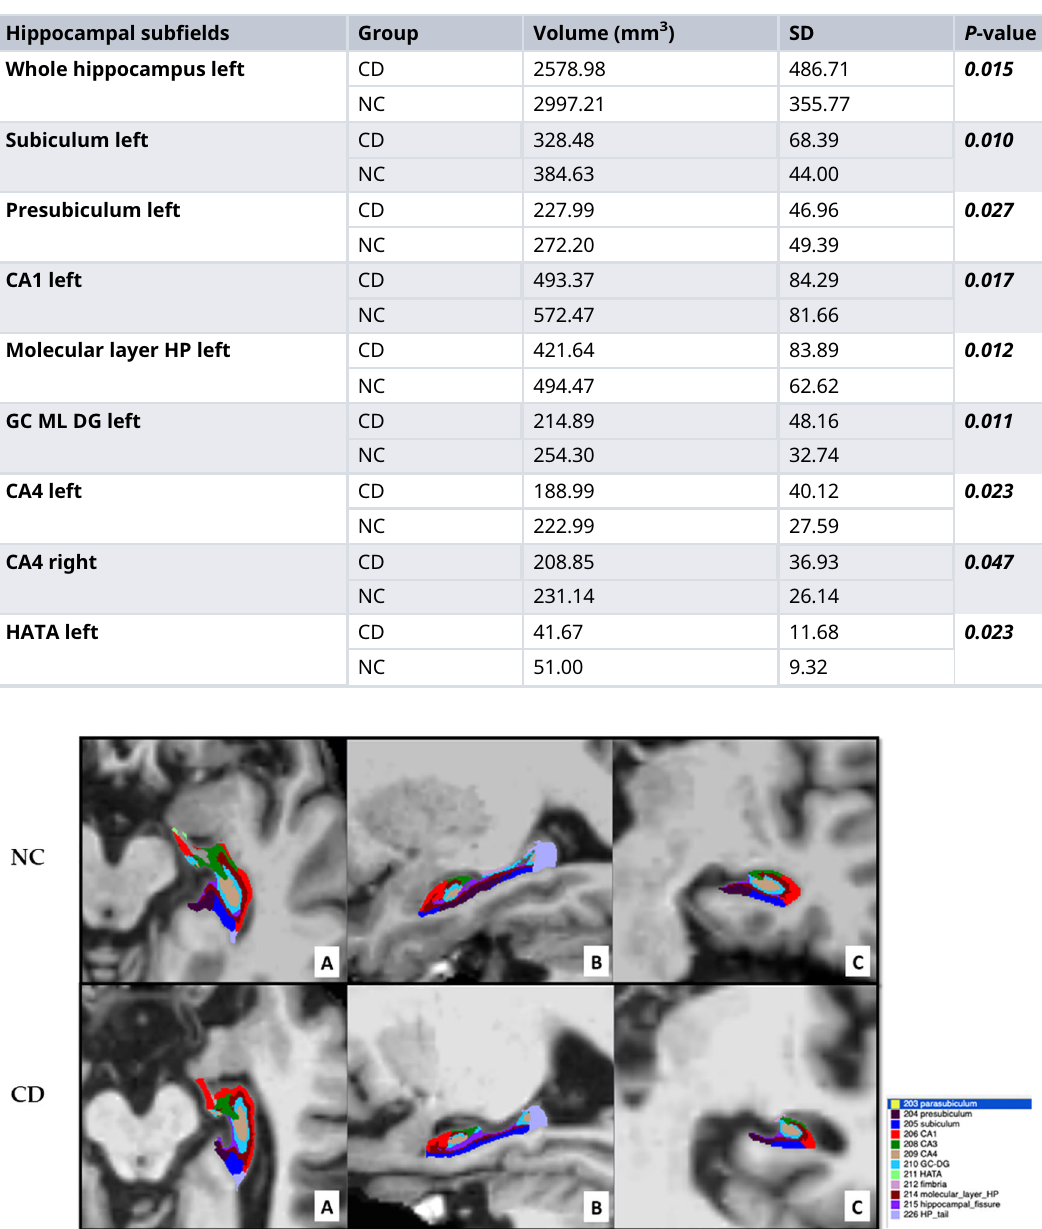
Table 2. Significant differences of hippocampal subfields volume between the CD and NC groups. Comparisons were made using Mann-Whitney nonparametric